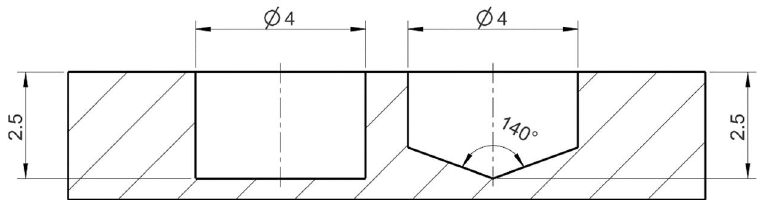
Figure 2. Schematic illustration of a blind hole with a flat bottom (HFB, left) and a blind hole with conical bottom (HCB, right); both Ø 4 mm, 2.5 mm drilling depth.